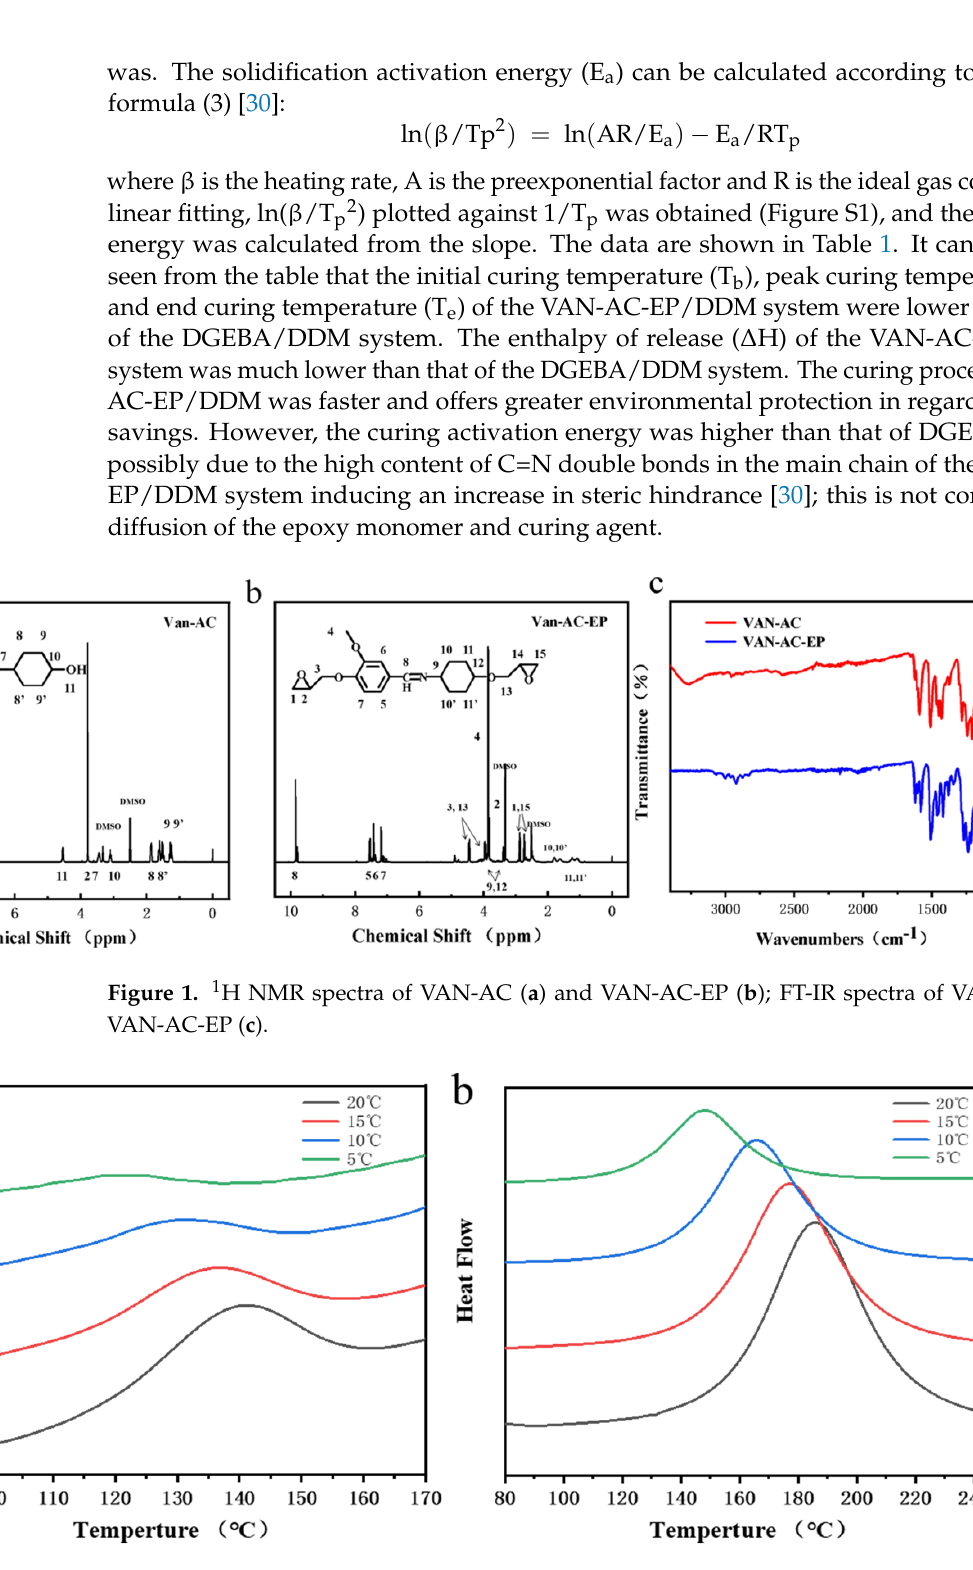
Figure 2. DSC curves of ( a ) VAN-AC-EP/DDM and ( b ) DGEBA/DDM curing processes. Table 1. Curing process data of VAN-AC-EP/DDM and DGEBA/DDM.